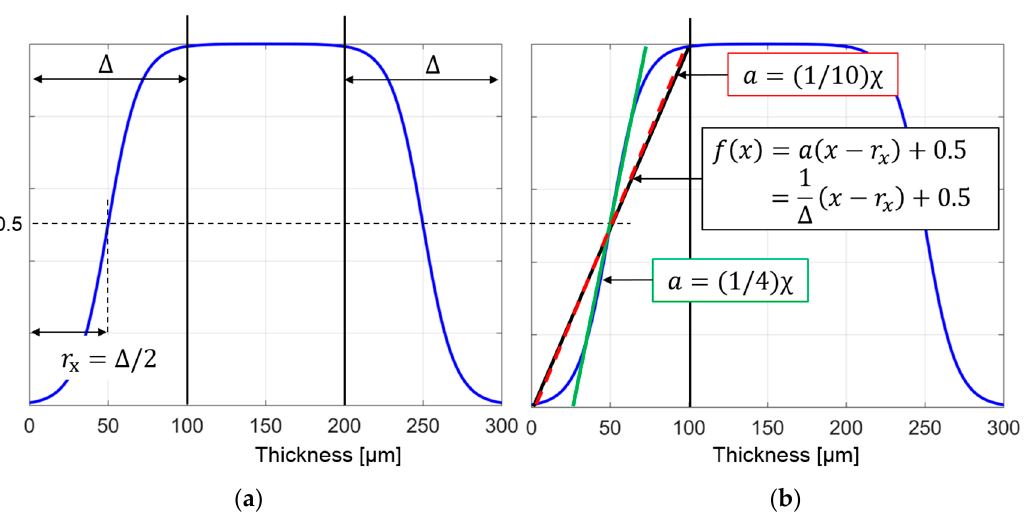
Figure 3. ( a ) Gradient region Δ , where the conductivity gradient is present. The position r = r x = Δ /2 has the highest gradient; ( b ) to determine χ by Δ , a straight line f ( x ) = a ( x − r x ) + 0.5 = (1/ Δ )( x − r x ) + 0.5 is used, where the best approximation is shown by Δ = 10 χ [10].